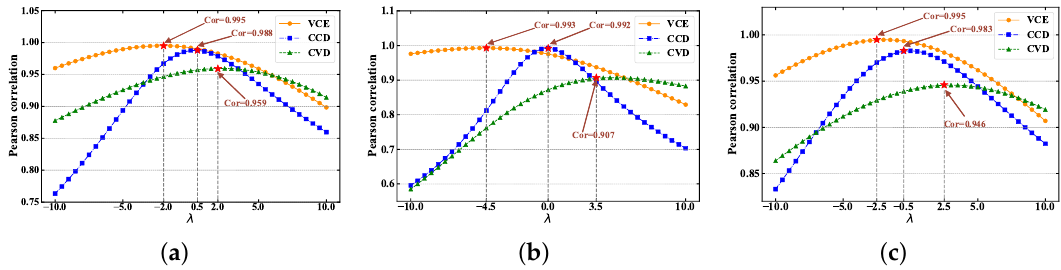
Figure 5. The Pearson correlations between CCD , CVD , VCE and RUL with different transformation parameters λ : ( a ) Battery #5; ( b ) Battery #6; ( c ) Battery #7.